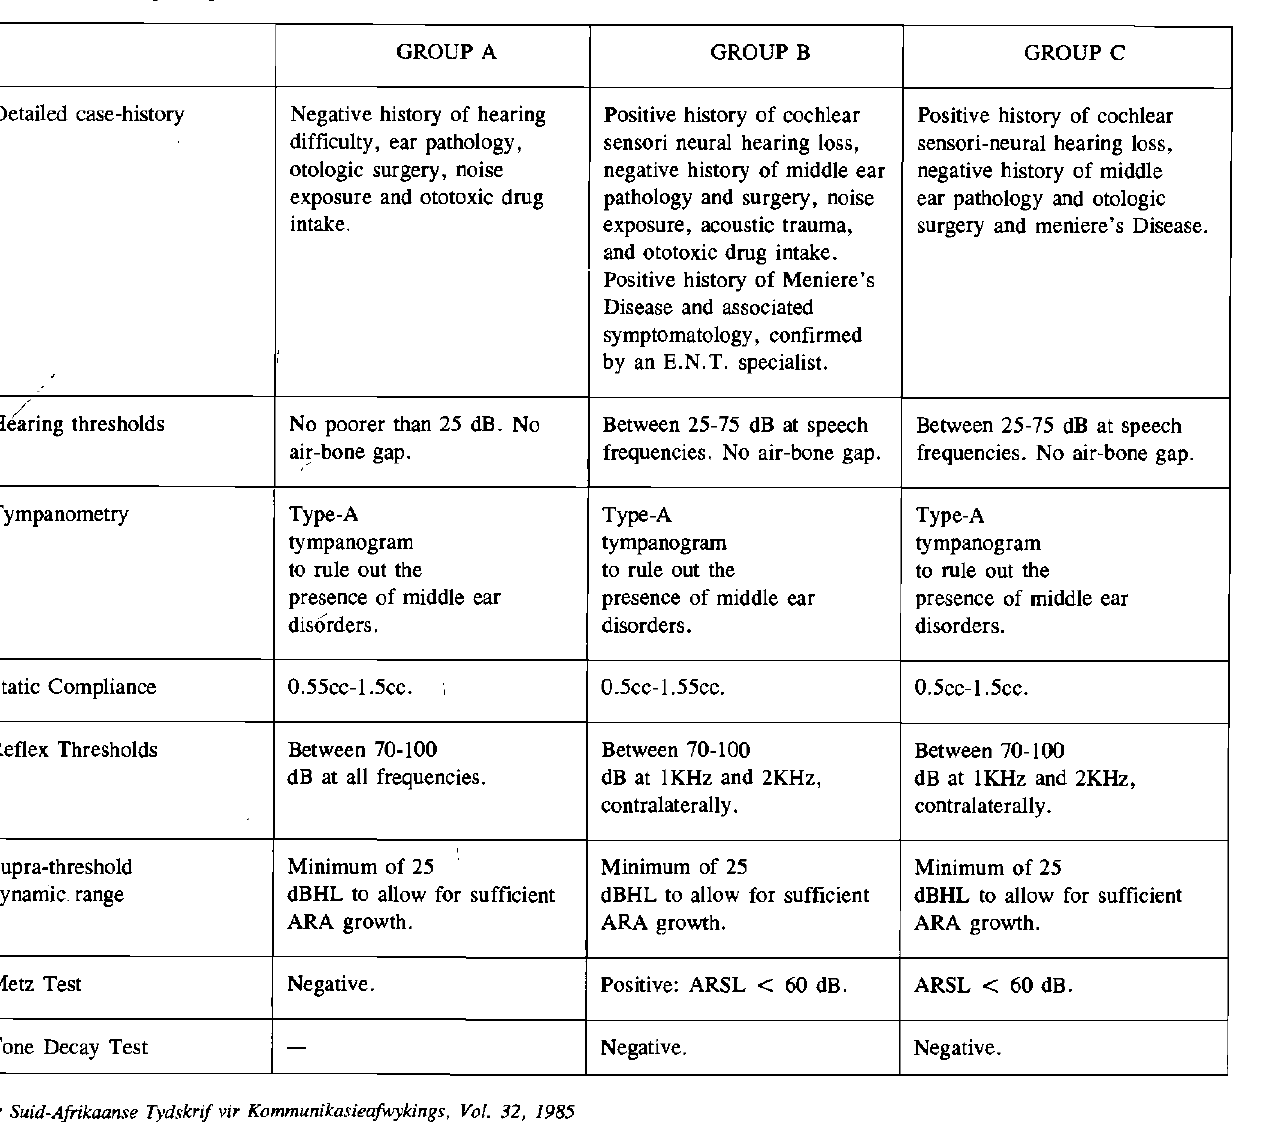
Table 1 Summary of specific criteria for subject selection and